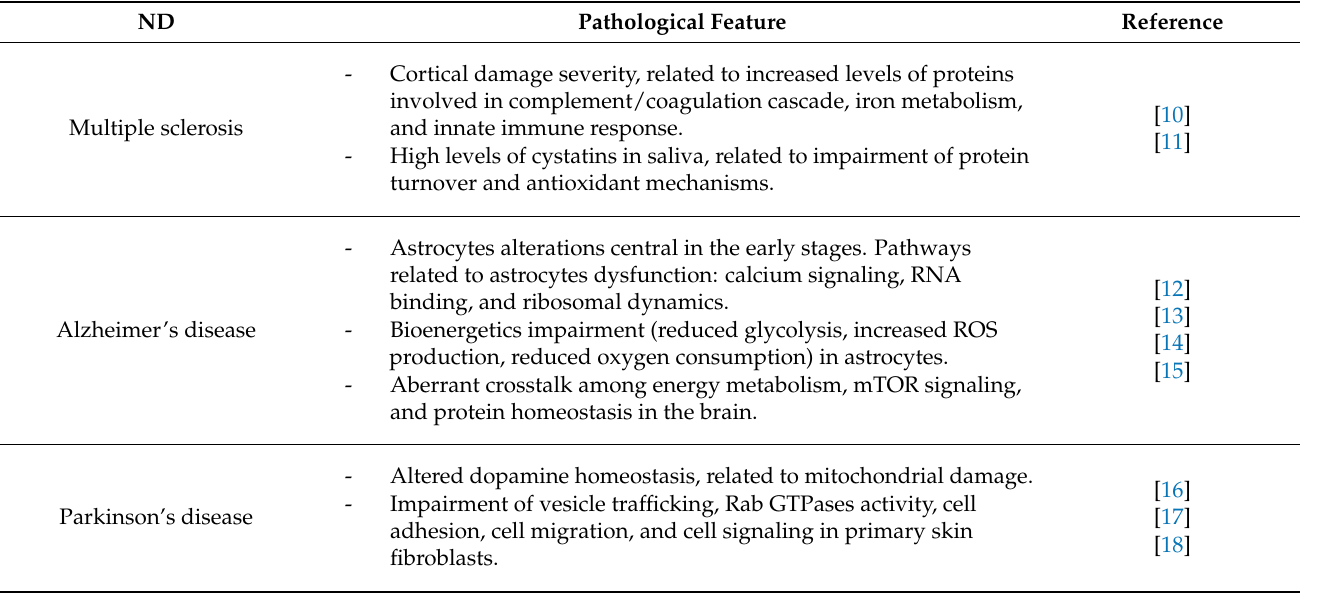
Table 1. Pathological mechanisms of MS, AD, and PD, recently unveiled by Italian proteomics studies. Pathological